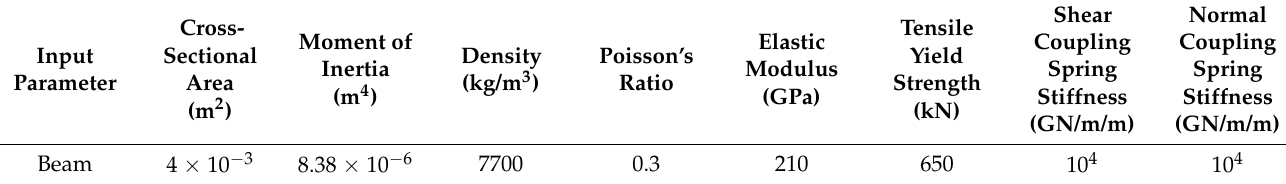
Table 7. Input parameters of the beam structural element.